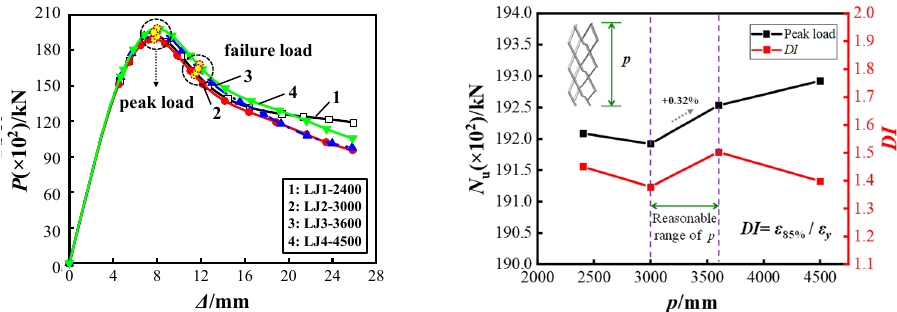
Figure 21. Load–displacement curves with different pitches.